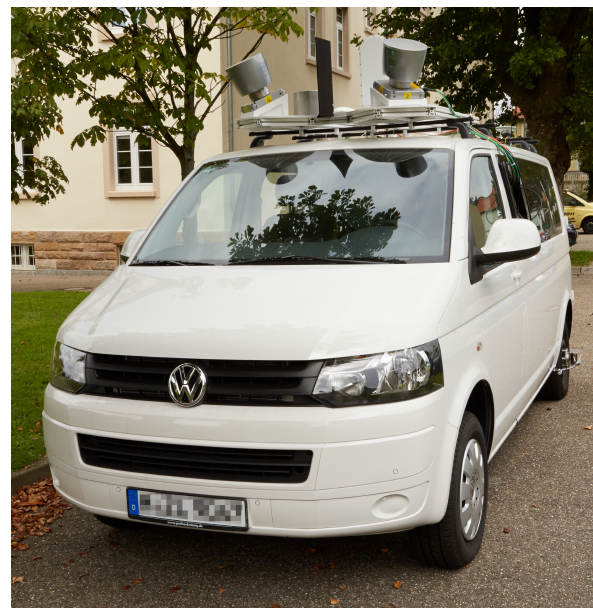
Figure 1. Sensor vehicle used for the experiments.